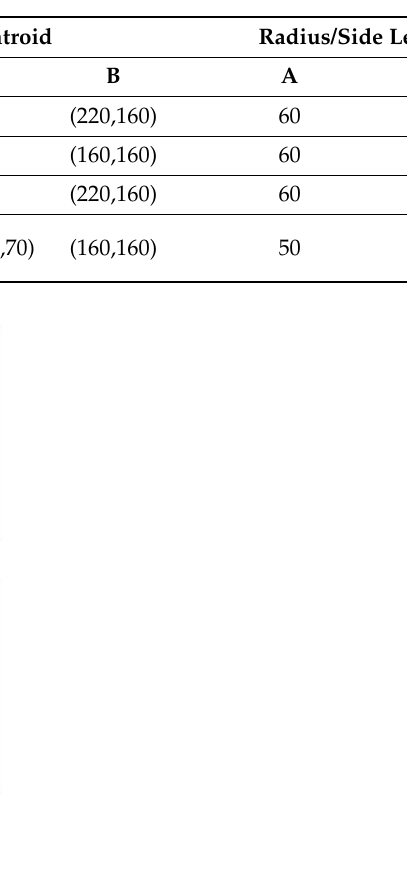
Table 3. Initial state of four cases.